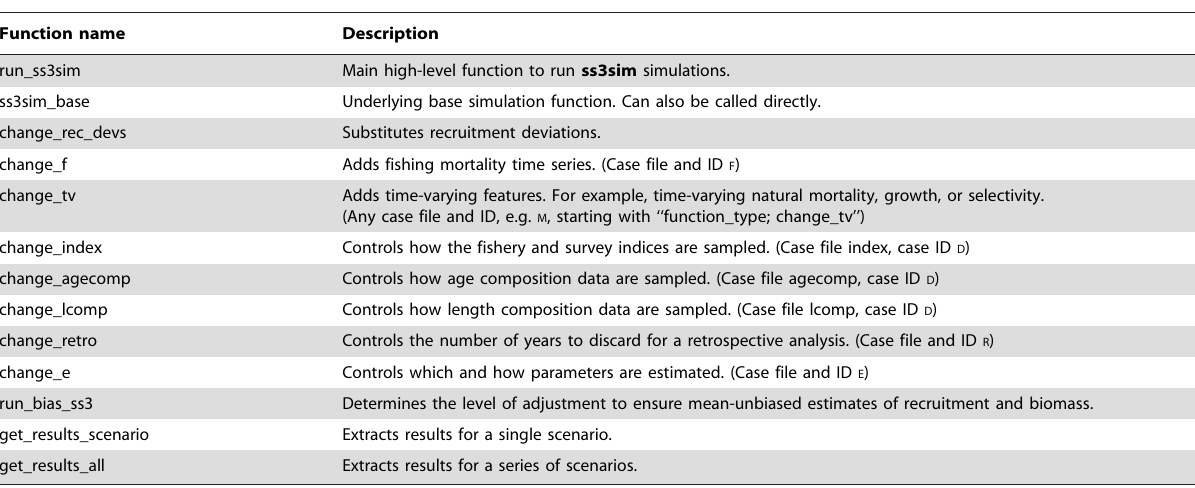
Table 1. Main ss3sim functions and a description of their purpose.